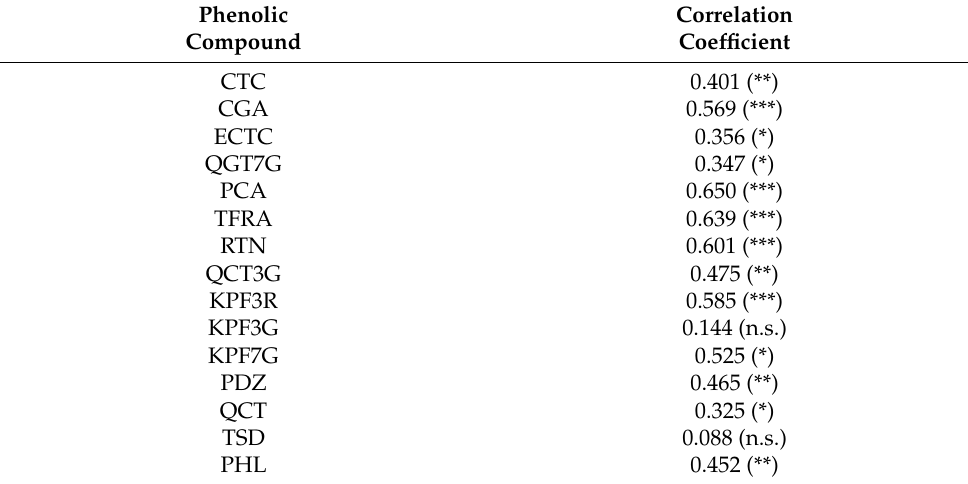
Correlation Coefficient